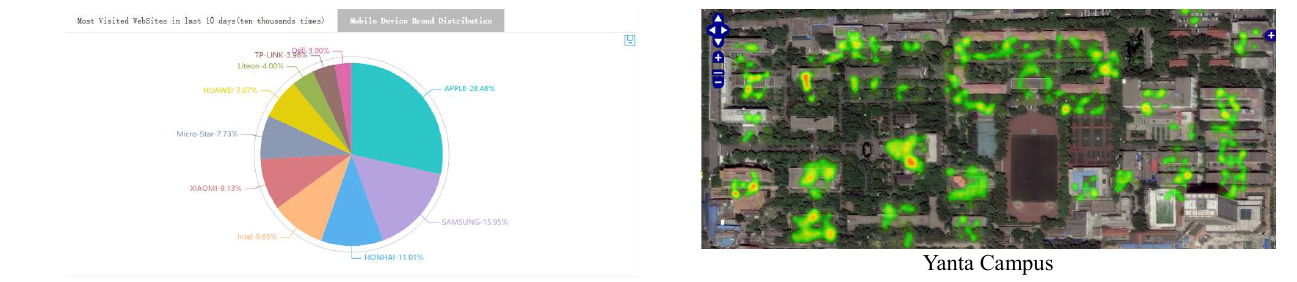
Figure 9. Brand distribution Distribution of mobile devices’ brand used by staffs and students (Figure 9).